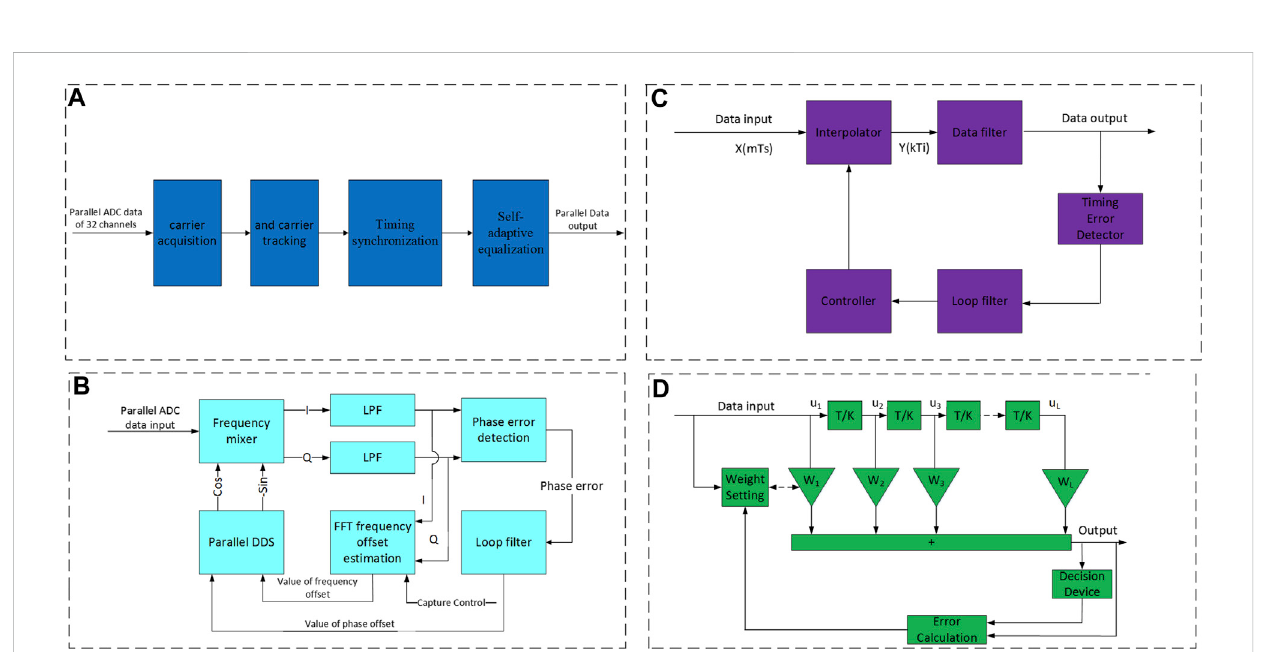
FIGURE 4 (A) Block diagram of BPSK digital demodulation. (B) Carrier recovery. (C) Parallel Gardner synchronization. (D) LMS